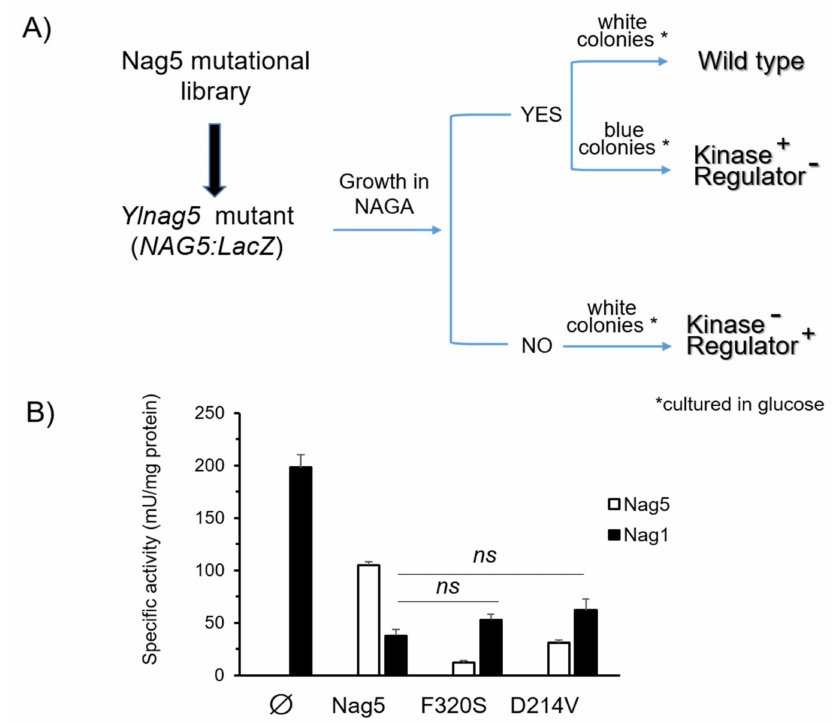
Figure 5. ( A ) Flow chart of the procedure to isolate mutant forms of YlNag5 fulfilling different functions of the protein. An Ylnag5 mutant strain bearing a fusion of the YlNAG5 promoter to lacZ was transformed with a library of randomly mutated YlNAG5 ; transformants were selected on glucose medium (denoted by an asterisk) and screened as shown in the figure. ( B ) Activity of NAGA kinase (Nag5) and NAGA-6-P deaminase (Nag1) in the indicated strains grown in glucose. Measurements are mean values of three independent cultures with their standard deviations. The differences in Nag5 activity between the mutated variants and the native Nag5 were highly significant ( p < 5 × 10 − 5 ), while those of Nag1 activity were not significant (ns) as determined by 2-tailed Student’s test. ∅ , denotes the void